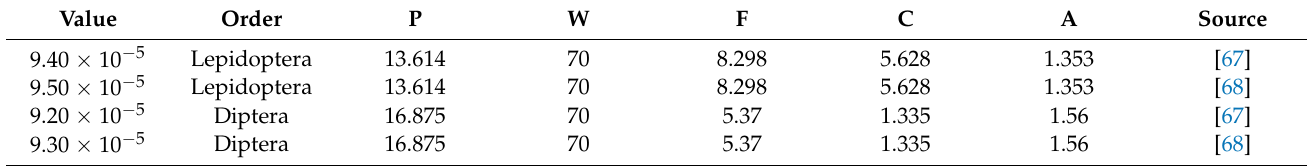
Table A8. Nutrient content of insect cells with calculated specific heat